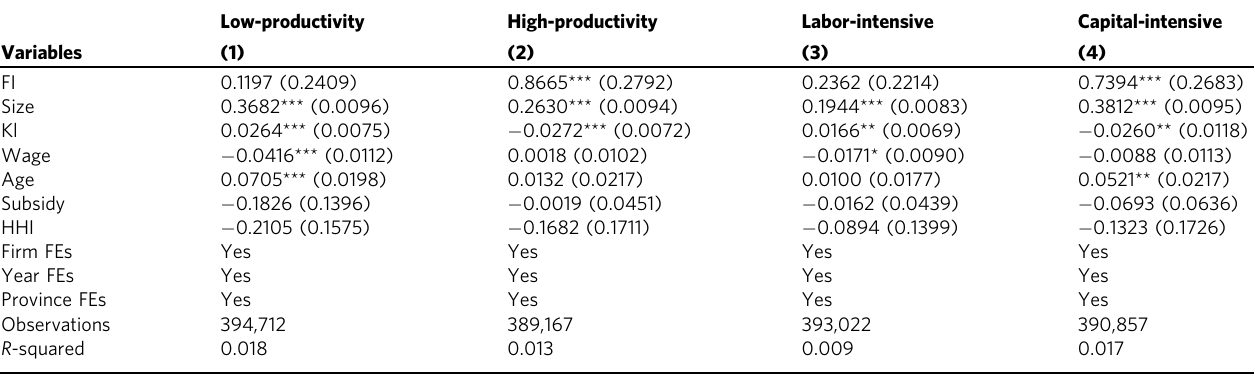
Table 5 Regression results by different types of productivity and factor intensity.